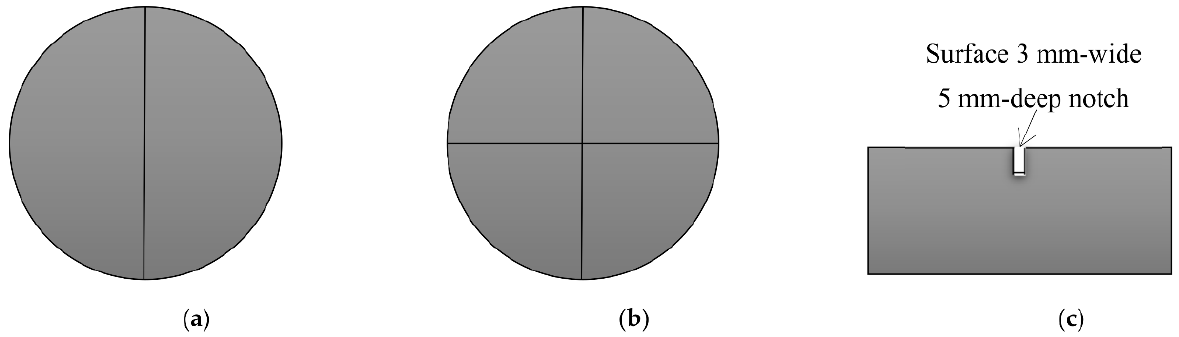
Figure 10. Suggested surface-notched specimen of Abid et al. [69]. ( a ) Surface line notch. ( b ) Surface cross notch. ( c ) Section of the notch.